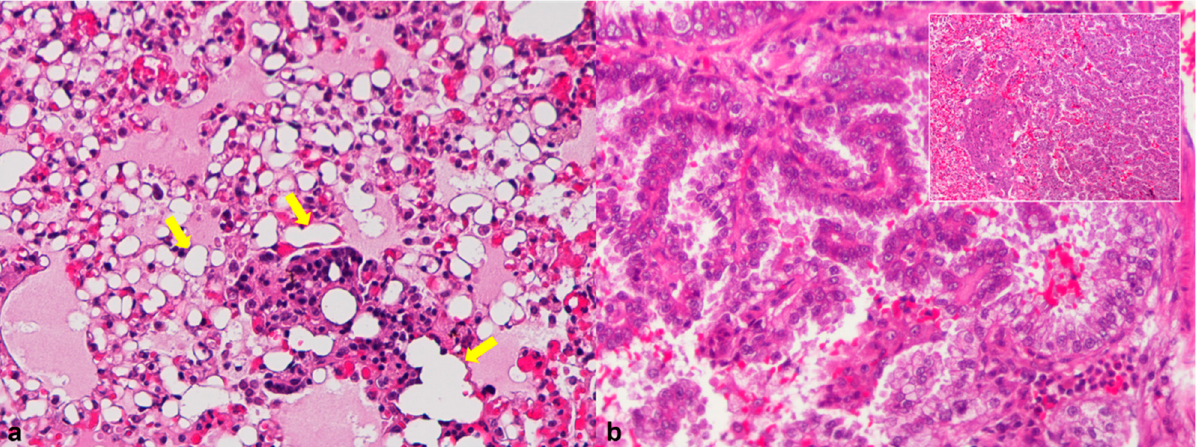
Figure 2. African pygmy hedgehog, lung. ( a ) Case 4, Lipoid pneumonia. Intra-alveolar and interstitial accumulation of lipid-laden macrophages (arrows; HE, 200 × ); ( b ) Case 6, Pulmonary adenocarcinoma. Population of neoplastic epithelial cells arranged in a papillary pattern (HE, 200 × ). Inset: presence of squamous differentiation in same areas of the neoplastic mass (HE, 100 × ).